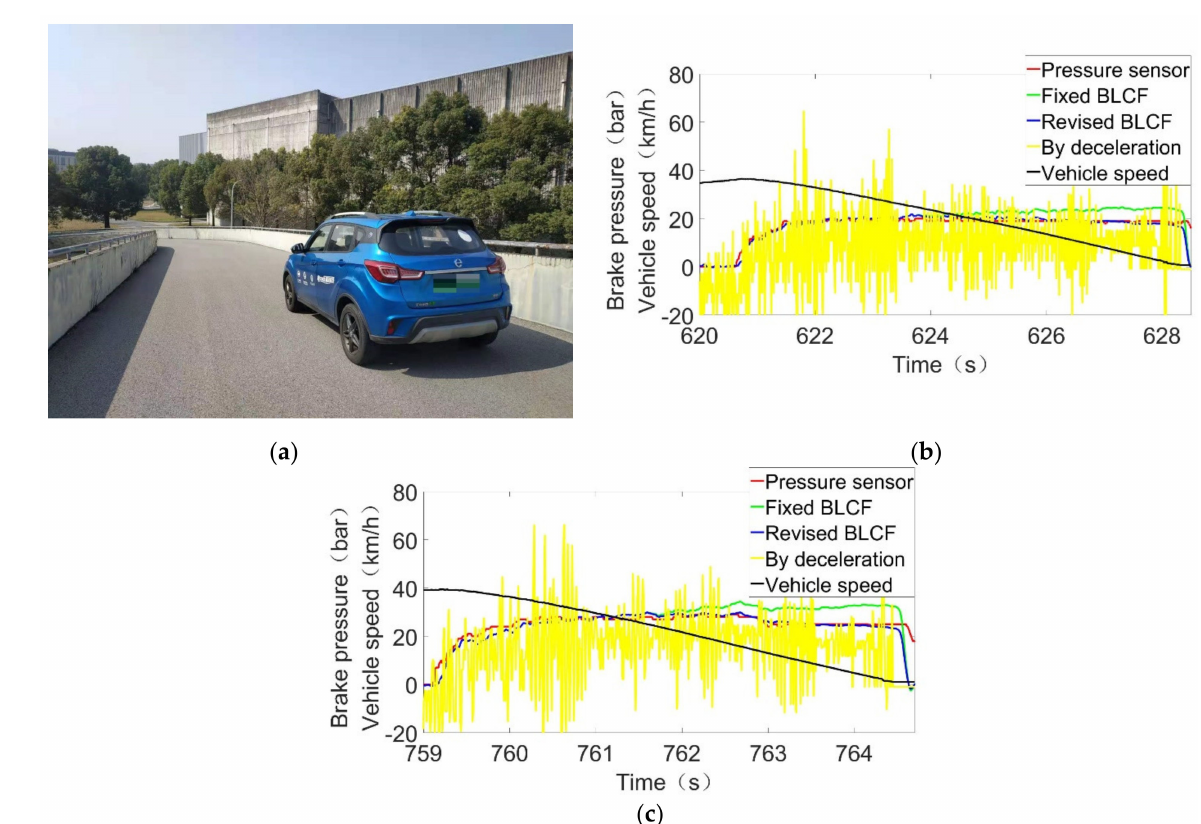
Figure 15. Test results of MCPE on the downhill: ( a ) Test vehicle on the downhill, ( b , c ) show the test